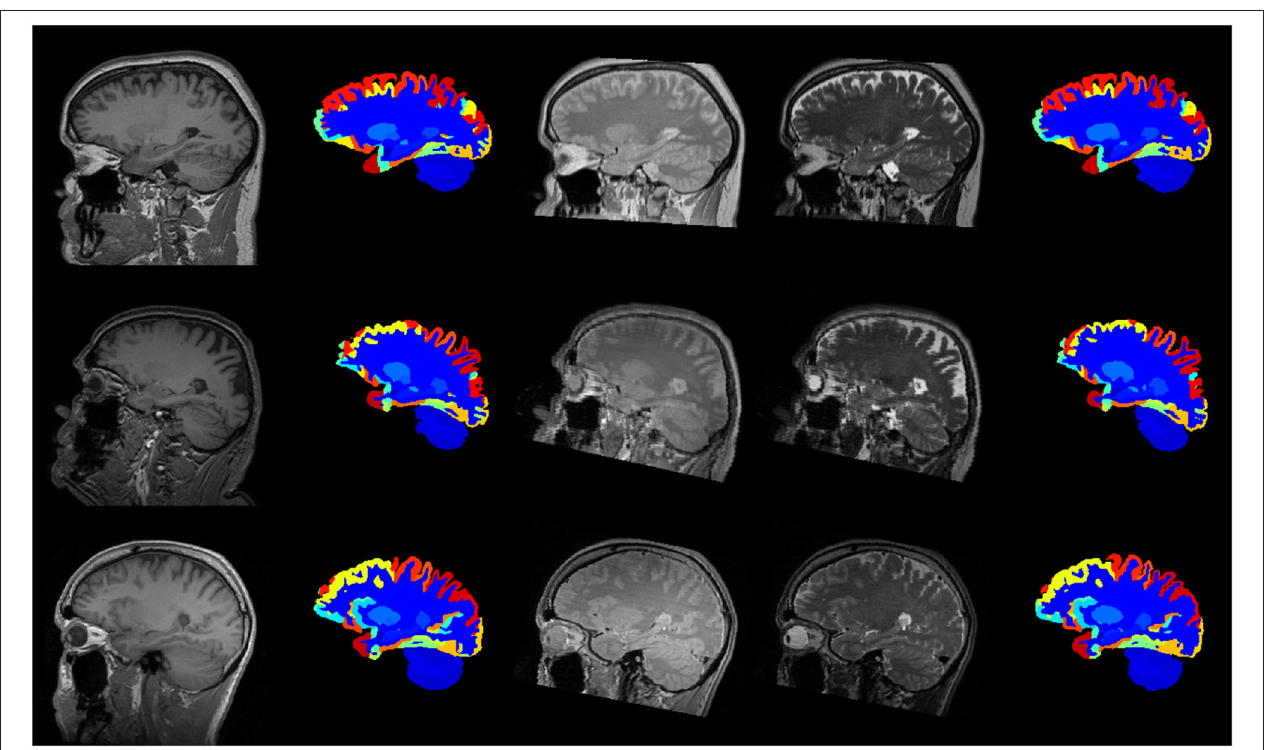
FIGURE 11 | Example labellings of different modalities from three different scanners. First column: T1-weighted scan. Second column: Labelled T1-weighted scan. Third and fourth columns: PD- and T2-weighted scans. Fifth column: Labelled PD- and T2-weighted scans. First row: Guys Hospital; Second row: Hammersmith Hospital; Third row: Institute of